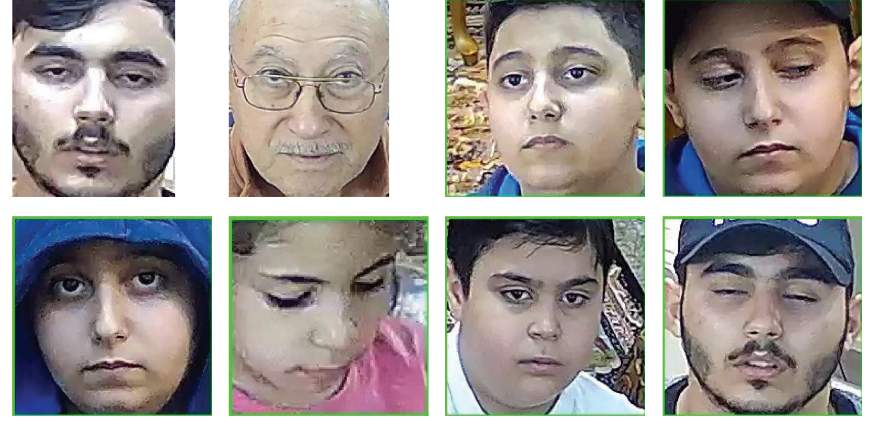
Figure 2: Faces with permission class.